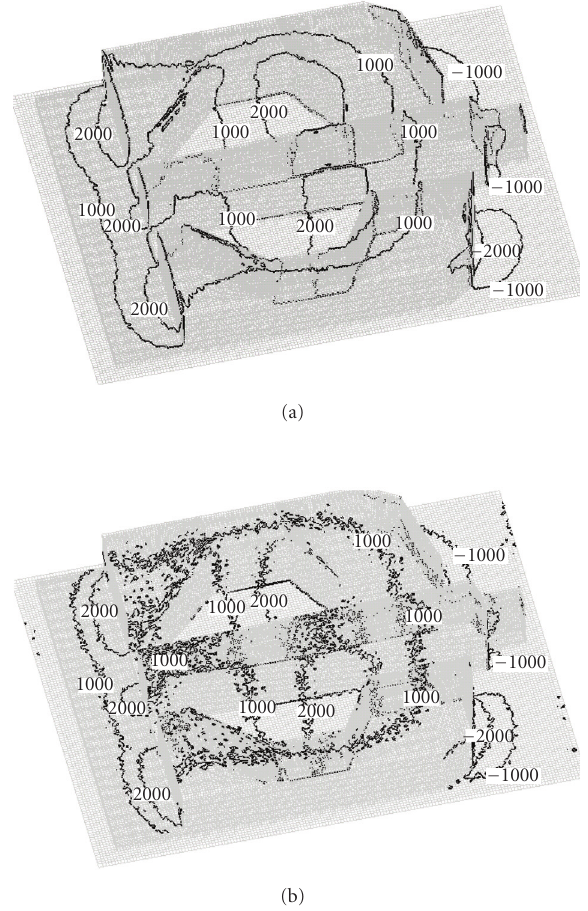
Figure 10: The contours of p − p 0 (Pa) for H min = 60nm and U = 10m / s by IP method (a) and DSMC method (b), cited from